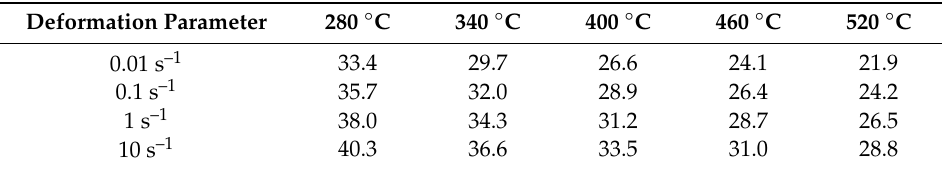
Table 2. The lnZ of Al–4.8Mg alloy under various deformation conditions calculated by average Q. Deformation Parameter 280 ◦